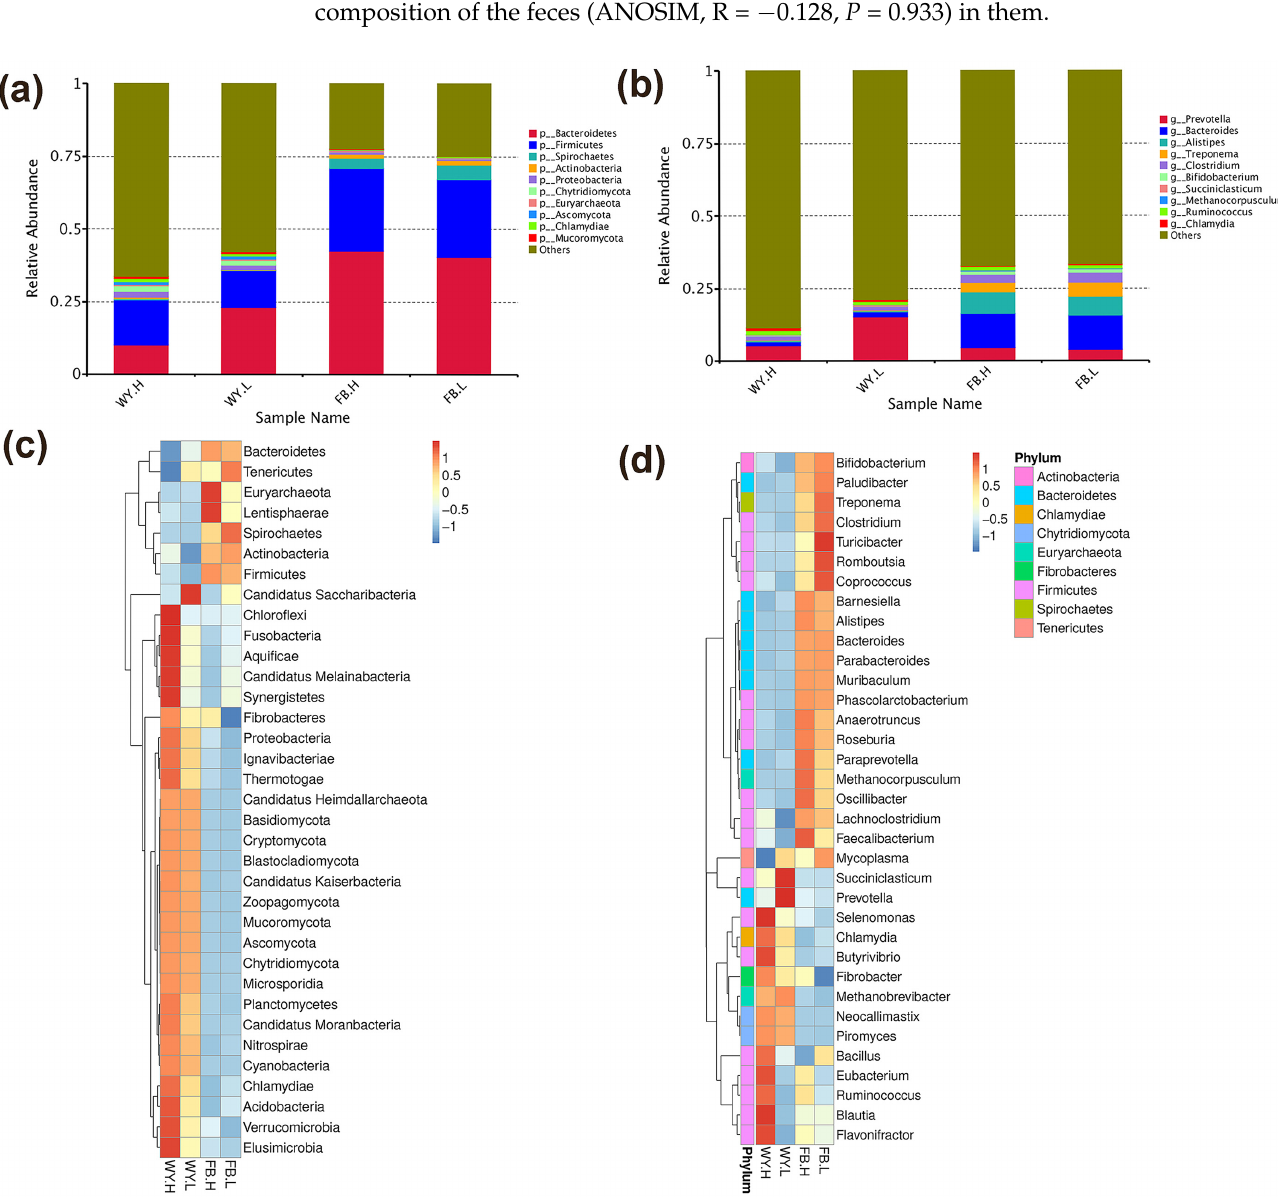
Figure 1. Analysis of relative species abundance at the phylum and genus levels. ( a ) Histogram of relative abundance at the phylum level; ( b ) Histogram of relative abundance at the genus level; ( c ) Heatmap of relative abundance at the phylum level; ( d ) Heatmap of relative abundance at the genus level.